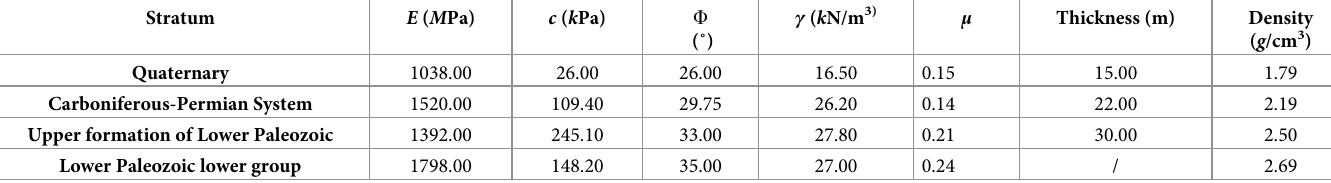
Table 2. Rock and soil parameters of slope